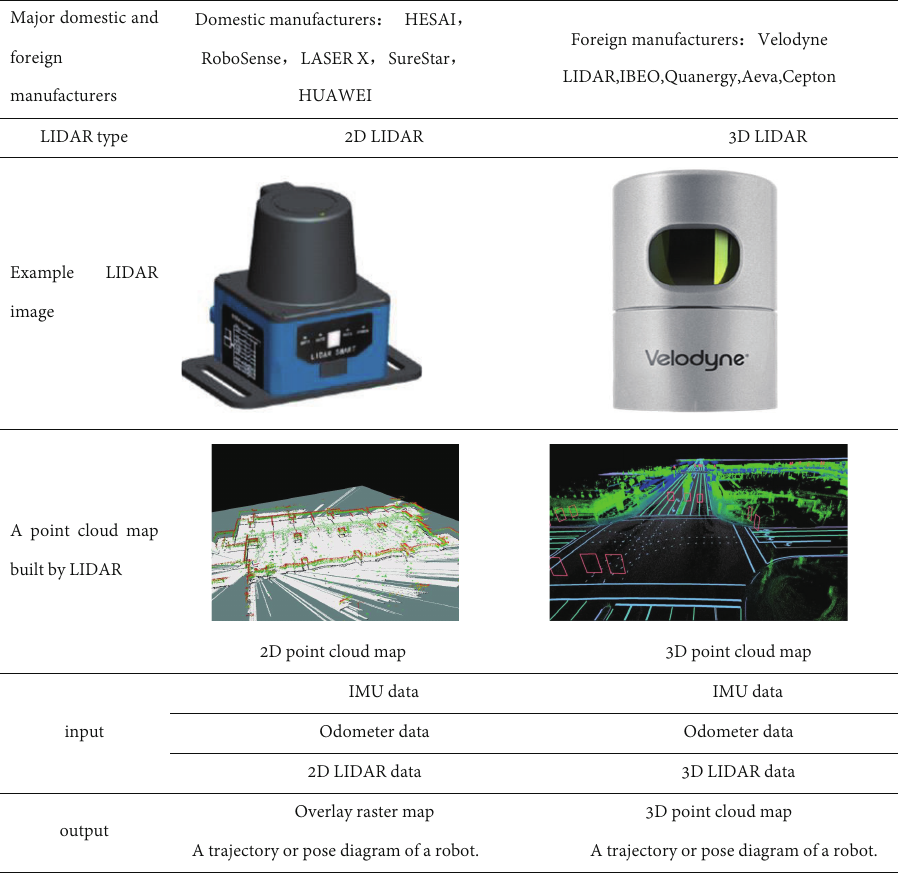
(cid:3) Figure 6. The map and input and output data of different types of LIDAR built by domestic and foreign manufacturers of LIDAR